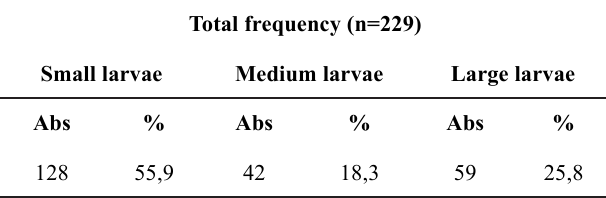
Table 3 . Absolute frequency (Abs) and percentage (%) of removed small according to size (larvae, medium and large) in M. montei